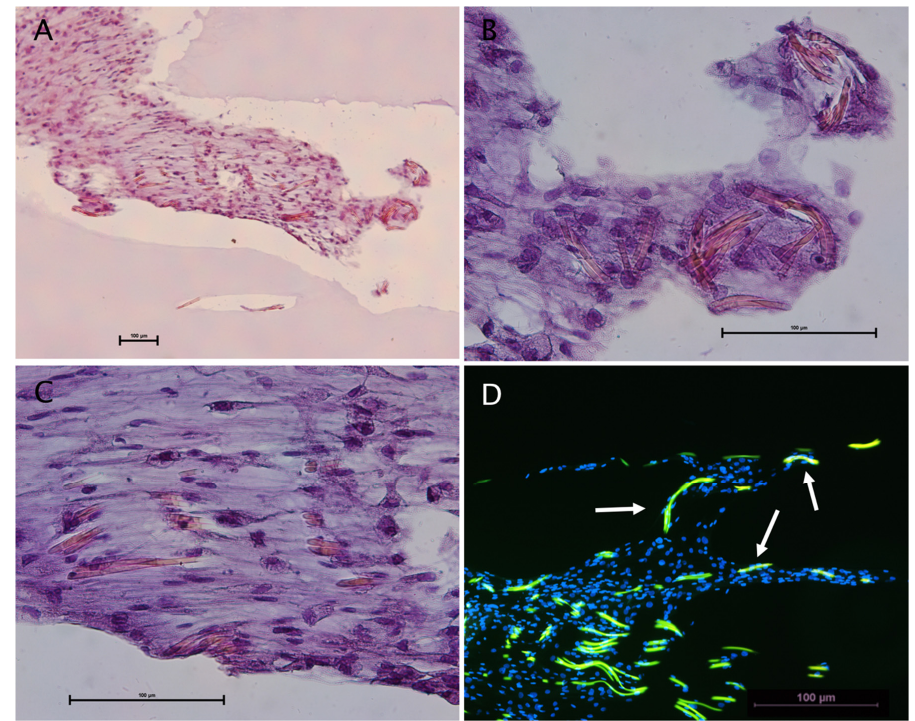
Figure 5. Illustrations of Schwann cells and ADSC co-cultures on spider silk: ( A – C ) Hematoxylin & Eosin staining showing cells equally distributed around the silk fibers; and ( D ) immunostaining with autofluorescence of the silk (green) and cell nuclei stained with DAPI (blue). Cells attached to the silk fibers are marked by the white arrows.